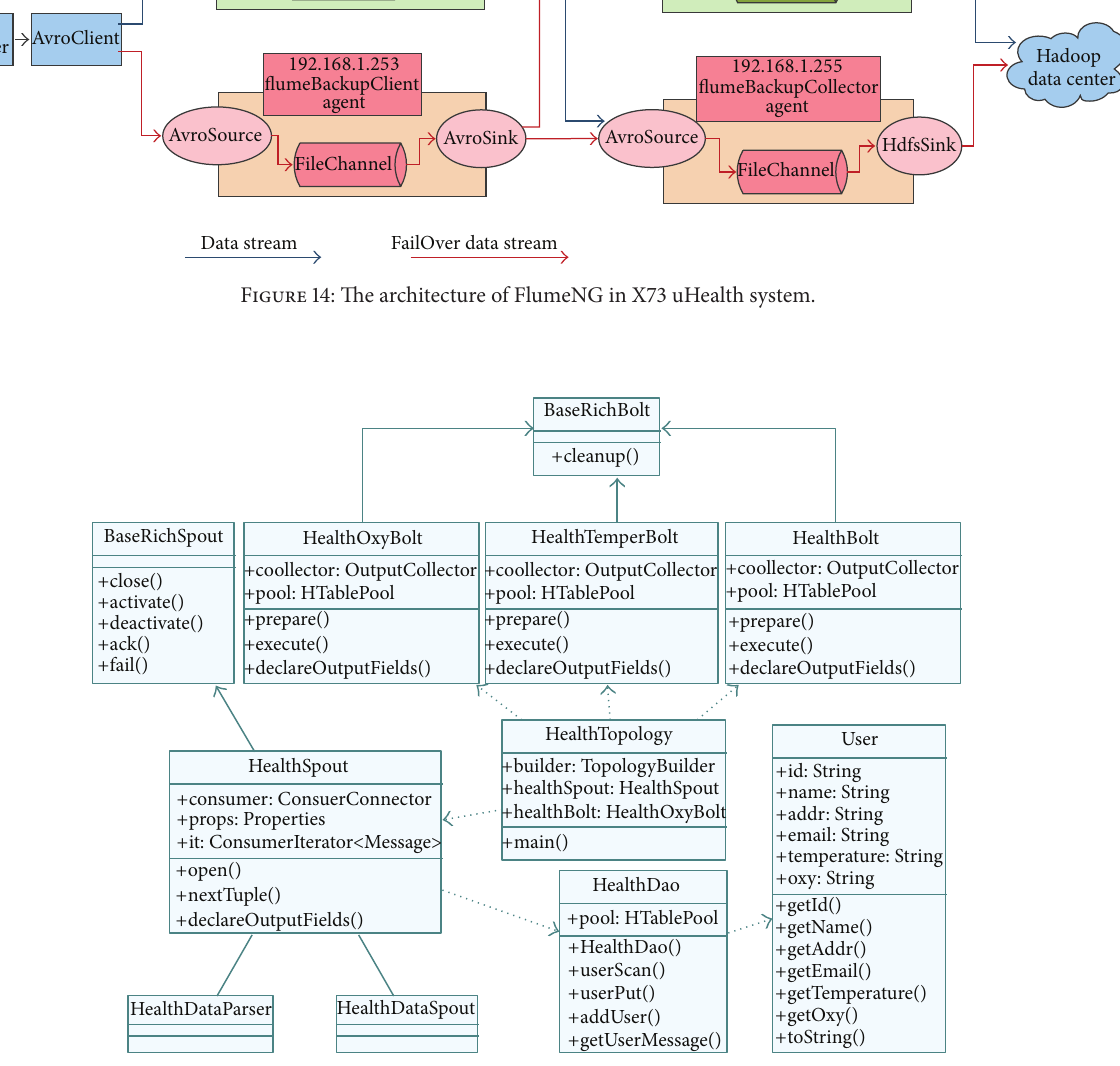
Figure 15: The UML Diagram of the X73 uHealth Cloud